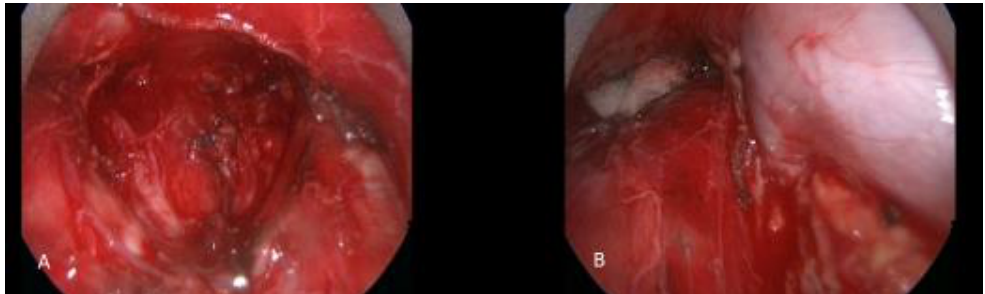
Figure 2. A patient with thymic carcinoma with suspicious mediastinal lymph node metastasis underwent cervical video mediastinoscopy and excision of the mediastinal lymph nodes. ( A ) Subcarinal region after complete removal of lymph node packet. ( B ) Right paratracheal region. The azygos vein and superior vena cava are seen skeletonized after lymphadenectomy.